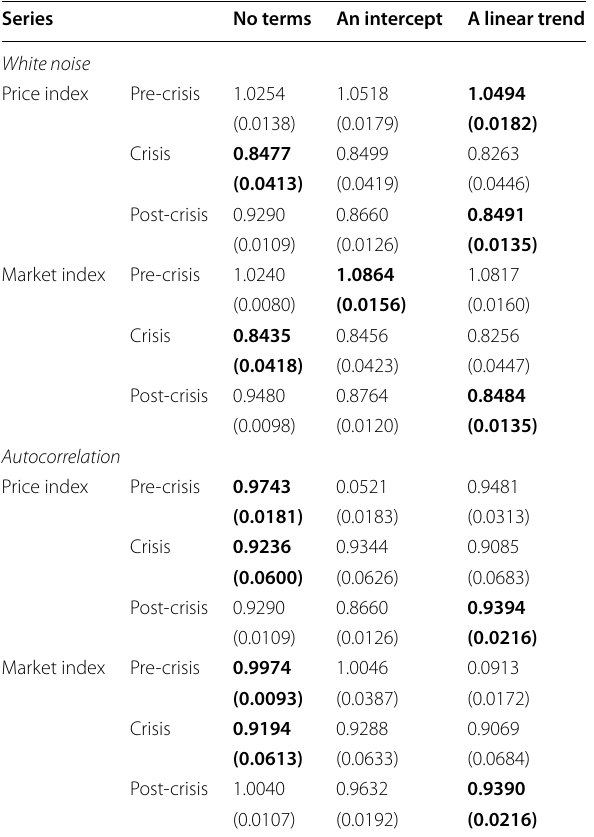
Table 7 Estimates of d for the pre- and post-crisis periods (logged